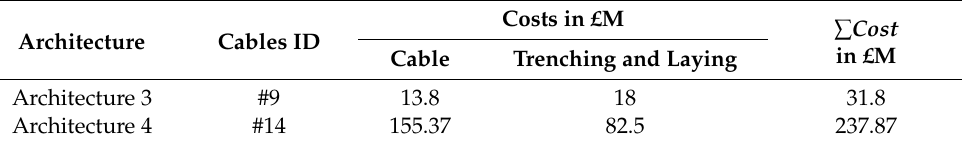
Table 11. DC-cable and trenching cost